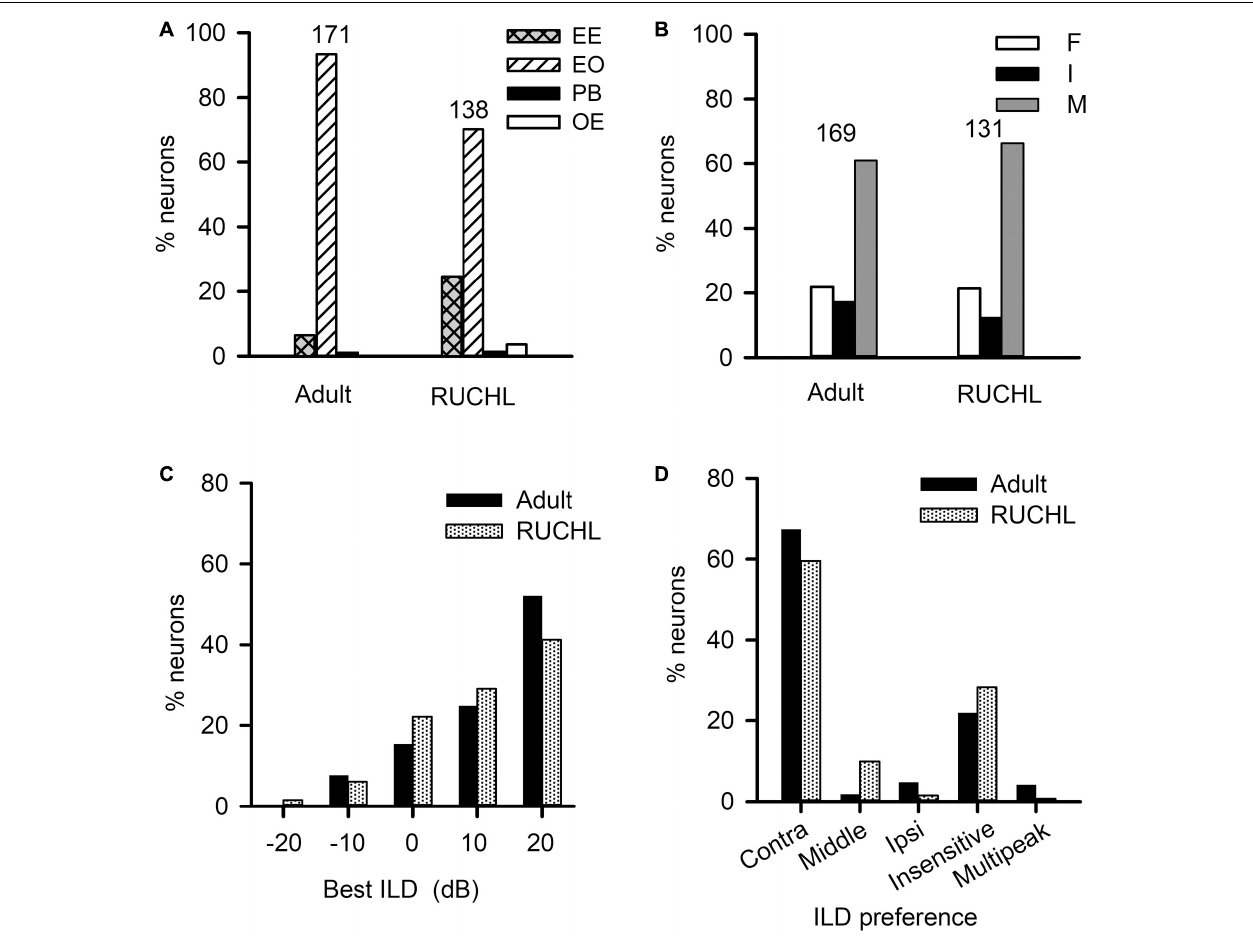
FIGURE 10 | The effects of reversible unilateral conductive hearing loss (RUCHL) at young age on the monaural response types and the binaural processing of rat AI neurons in adulthood. Data from the adult group were used as control for comparison. (A) The distributions in the monaural response types (i.e., EE, EO, OE, and PB). (B) The distributions of the binaural interaction types of AI neurons including both EE and EO neurons. The binaural interaction of each neuron was classified into one of the three categories: inhibitory (I), facilitatory (F), and mixed (M). Numbers shown on the top of the bars in panels A and B indicate the number of neurons in each group. (C) The distribution of the best ILDs of AI neurons. (D) The distributions of ILD preferences of AI neurons.